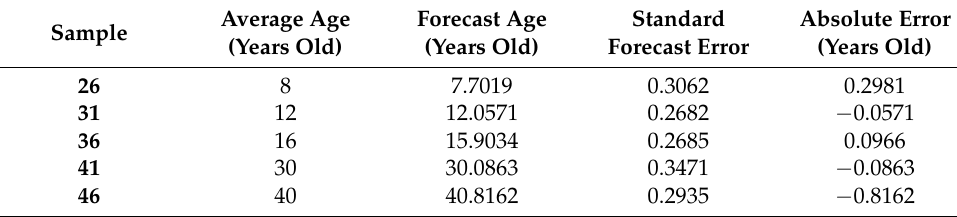
Table 13. Validation of the A5 model with five of the analyzed Amontillado